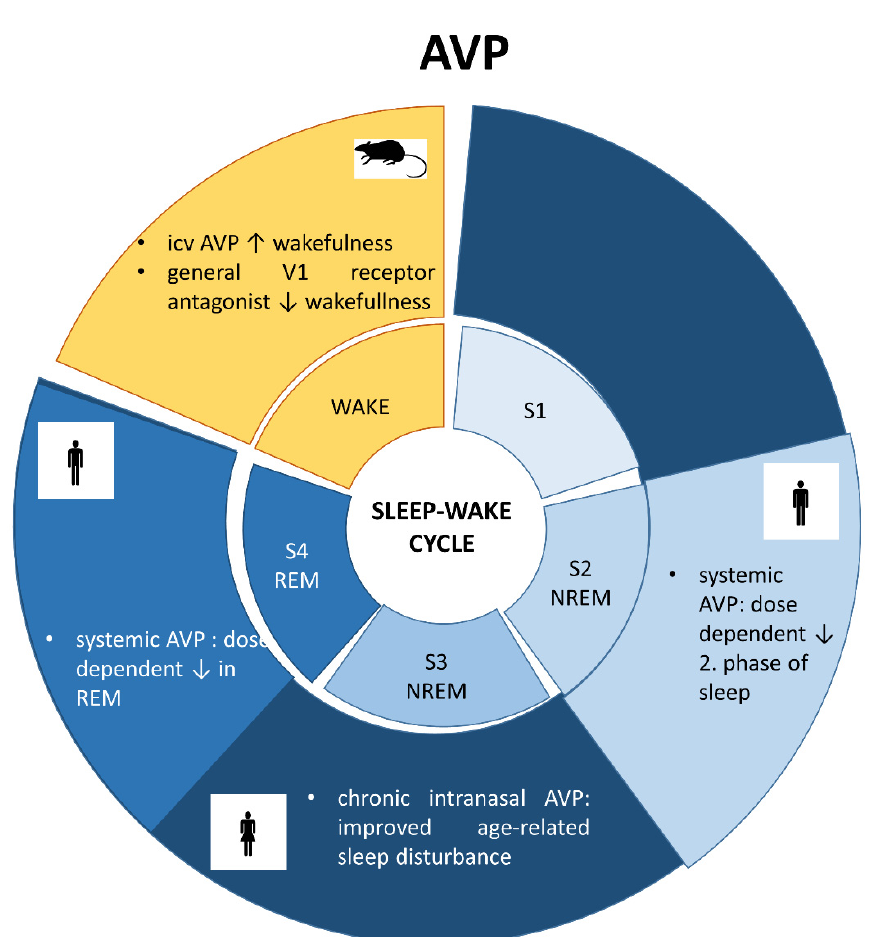
Figure 3 . Sleep stages and involvement of vasopressin (AVP). S1: first stage of sleep, S2: second stage of sleep, S3: third stage of sleep; REM: radip eye movement; NREM: non-REM stage; icv: intracerebroventricular administration .